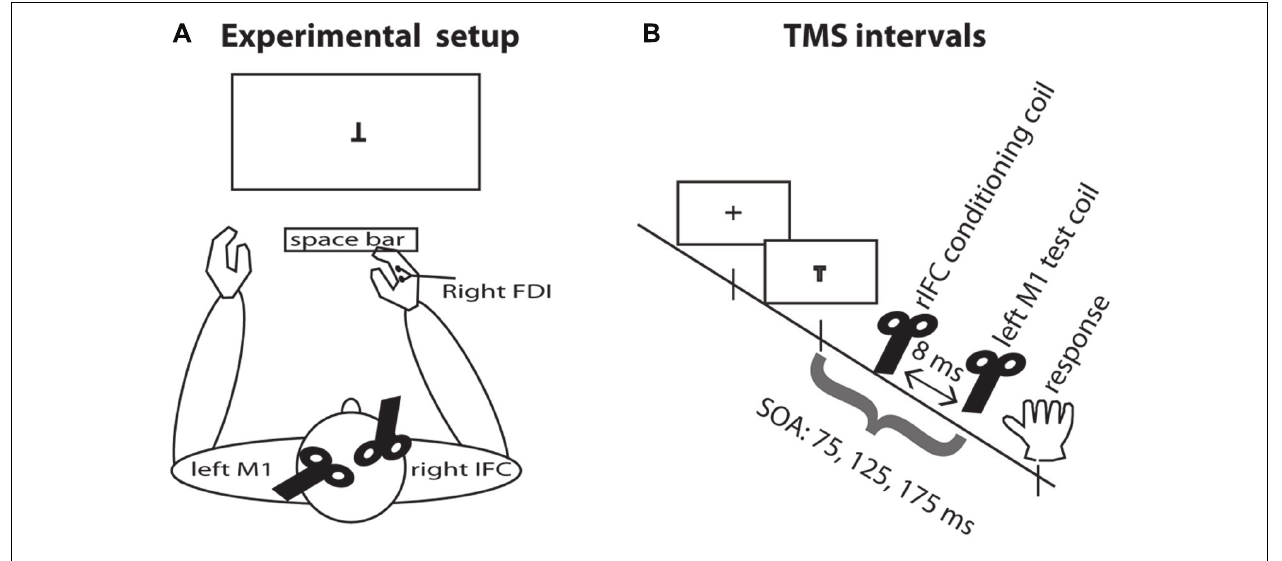
FDI muscle. (B) TMS intervals. A fixation cross appeared on the screen for 500–750 ms. On TMS trials, a pulse of TMS over the motor cortex was applied on one of three SOAs, either 75, 125, or 175 ms. On half the TMS trials, this pulse was preceded by a pulse over rIFC 8 ms